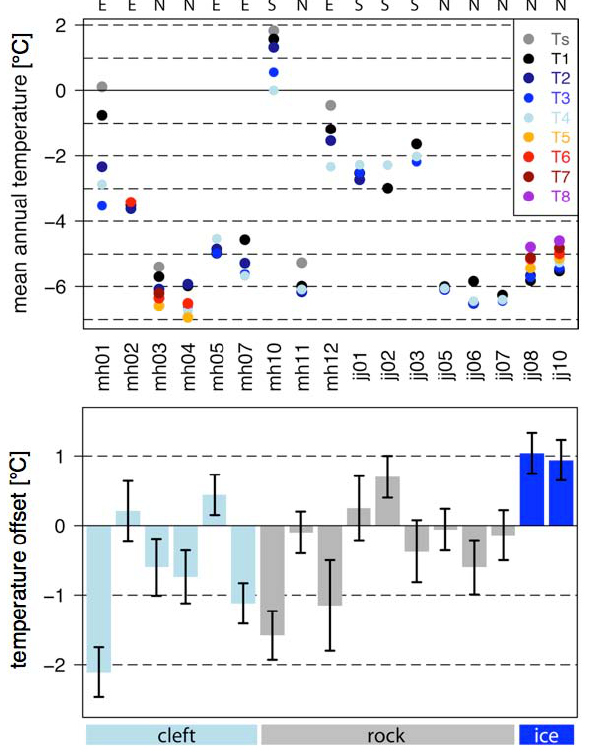
Fig. 9. Mean annual temperature (MAT) and temperature offset (TO) between cleft top and within cleft (light blue); in shallow rock boreholes (grey) and in ice (dark blue). The black error bars show the uncertainties U to of the temperature offset estimates on a 95% confidence level. The letters at the top indicate the main aspect of the locations (E=east, N=north, S=south). The location labels given in the middle of the figure help to read other attributes from Table 1. At the bottom, the location type is denoted, which corre- sponds to the colours of the bars from the thermal offset.